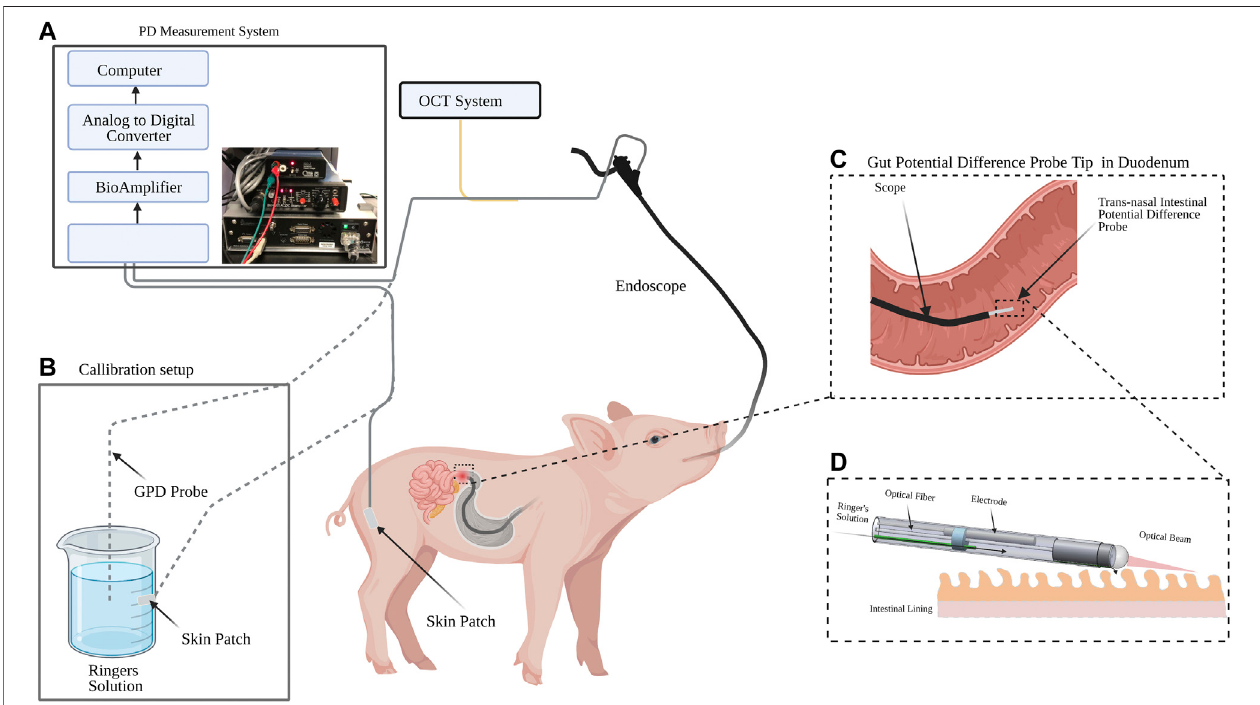
FIGURE 2 | Experiment schematic for gut potential difference (GPD) measurement in swine. (A) PD measurement system consisting of an isolation head-stage, a bioampli fi er, an analog-to-digital converter and a computer. (B) An offset zeroing setup made of a cup fi lled with Ringer ’ s solution and a skin patch. (C) The pig ’ s small intestine was intubated using a pediatric gastroscope and the IPD probe inserted through the working channel of the endoscope. The GPD signal was acquired via an isolation headstage and a bioampl fi er in the GPD measurement system. The GPD signal was converted to a digital signal and logged using a computer. Optical coherence tomography (OCT) M-mode images were simultaneously acquired. (D) Detailed view of the duodenum and the GPD probe.